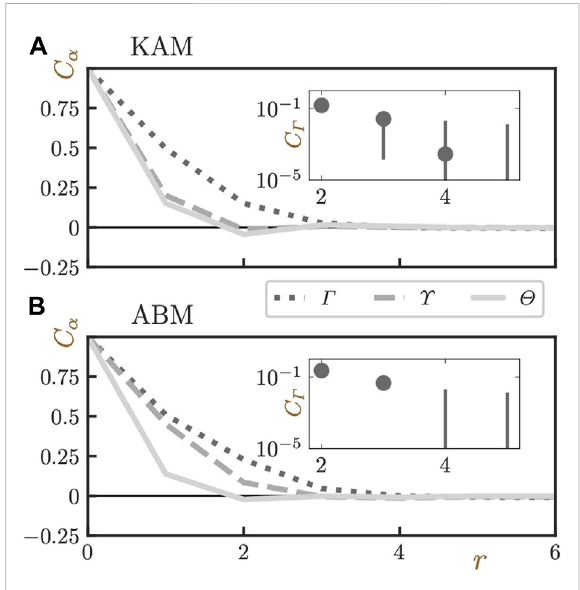
FIGURE 8 The spatial correlation functions of structural indicators α ( α ∈ { Γ , ϒ , Θ }), C α , as a function of the distance from the reference particle r .Resultsfor (A) KAM, (B) ABM systems.Differentlinestyles distinguish different indicators as shown in the legend. In the insets of both panels, the magni fi ed images of C Γ in the vicinity of C Γ = 0 with error bars. In these insets, the vertical axes are in the logarithmic scale. Although the values of C Γ are negative when markers are missing, the error bars are crossing C Γ =